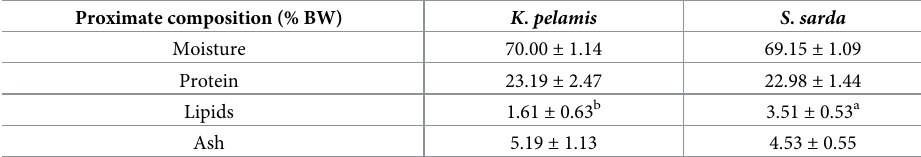
Data are presented as mean ± SD ( n = 6). Different letters (a,b) represent statistical differences between species (P < 0.05). Absence of letters indicates no statistical difference between species (P > 0.05). Body proximate composition of Katsuwonus pelamis and Sarda sarda (%